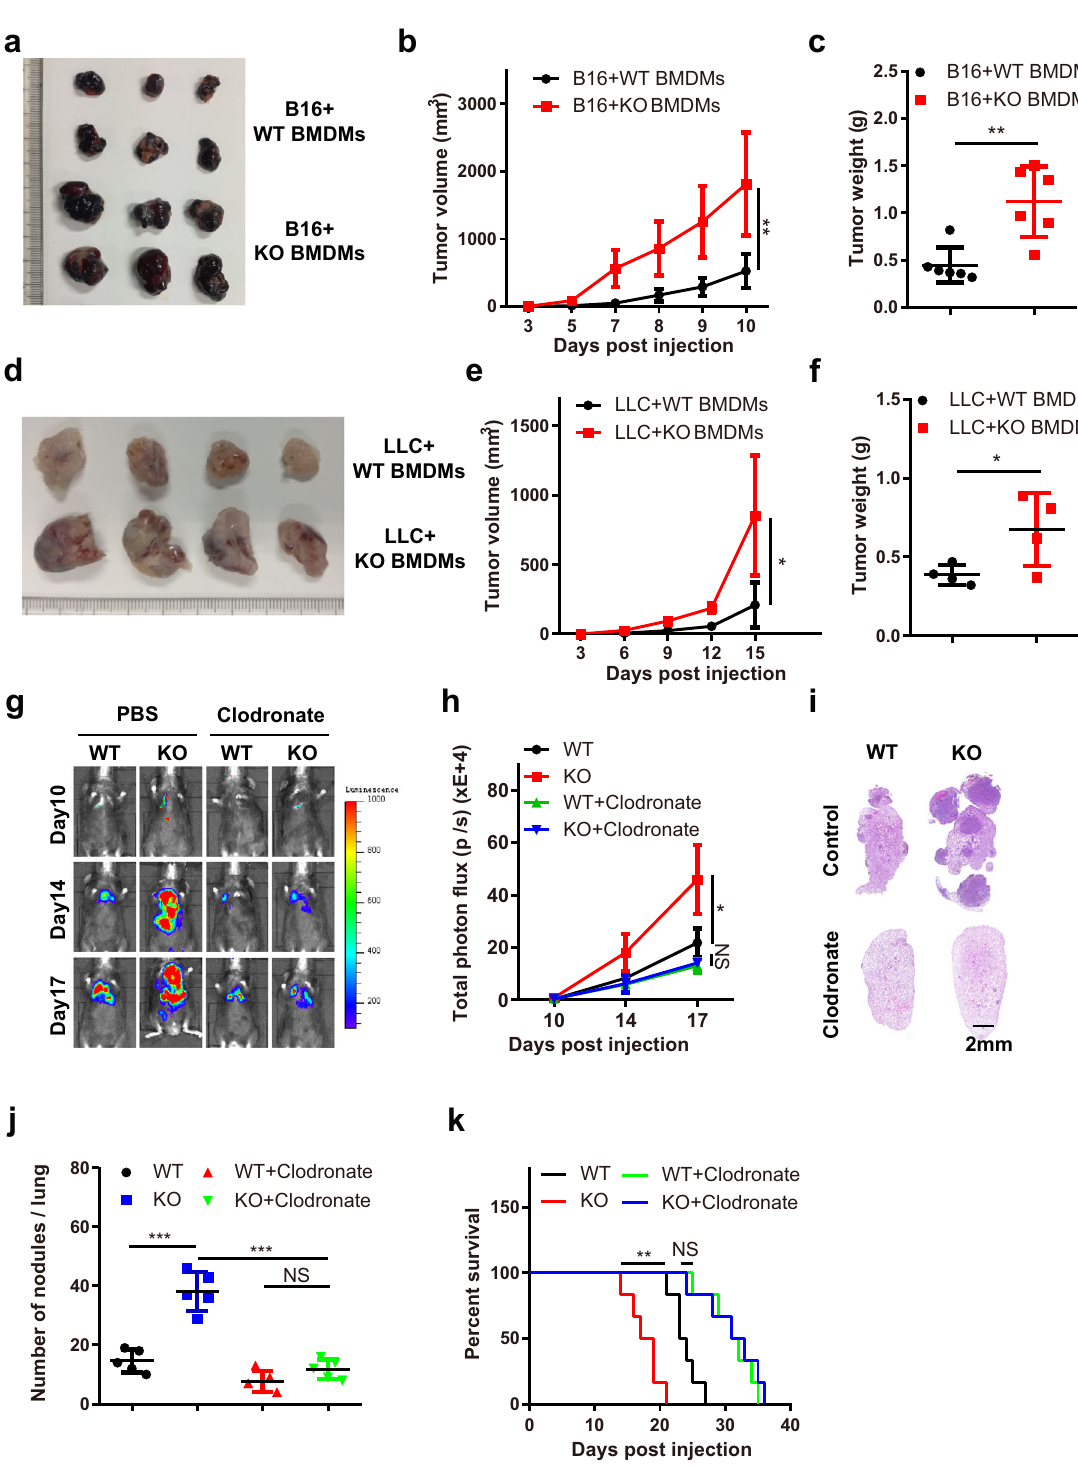
Fig. 2 Macrophages with Mettl3 depletion enhance tumour growth and lung metastasis. a – c WT mice were subcutaneously inoculated with 1 × 10 6 LLC cells mixed with 2.5 × 10 5 WT or KO macrophages. Tumours were dissected 10 days after inoculation and photographed ( a ). Tumour volume ( b ) and tumour weight ( c ) were recorded ( n = 6 mice per group). d – f WT mice were subcutaneously inoculated with 1 × 10 6 B16 cells mixed with 2.5 × 10 5 WT or KO macrophages. Tumours were dissected 15 days after inoculation and photographed ( d ). Tumour volume ( e ) and tumour weights ( f ) were recorded ( n = 4 mice per group). g – k WT and KO mice were injected with clodronate liposomes 2 days before experiments. Then, B16 cells were intravenously injected into the mice. Bioluminescence was measured at the indicated time points, and representative images are shown ( g ) and were quanti fi ed ( h ) ( n = 3 mice per group). Representative HE staining images of lung sections are shown ( i ). Lung metastatic nodules ( j ) ( n = 5 mice per group) and overall survival ( k ) ( n = 6 mice per group) were observed. Data are shown as the mean ± SD. P values were determined by a two-tailed t -test ( b , c , e , f , h and j ) and the Gehan – Breslow – Wilcoxon test ( k ). * P ≤ 0.05, ** P < 0.01 and *** P < 0.001. NS (non-signi fi cant) means P > 0.05. The source data are provided as a Source data fi